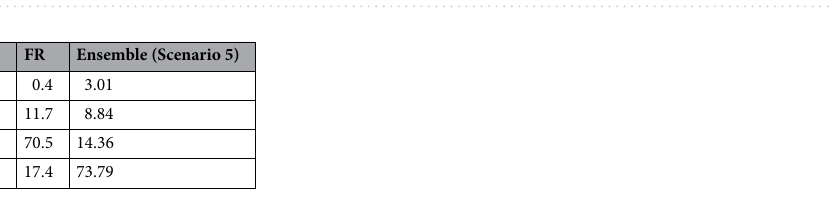
Table 2. The classes and area percentage of each class by scenario